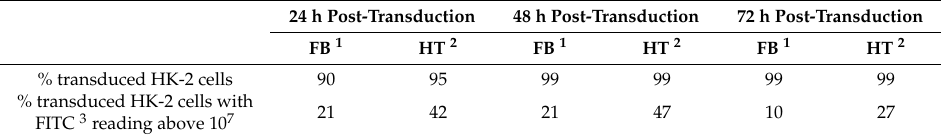
Table 1. Quantitative assessment of BacMam transduction of HK-2 cells by flow cytometry. 24 h Post-Transduction